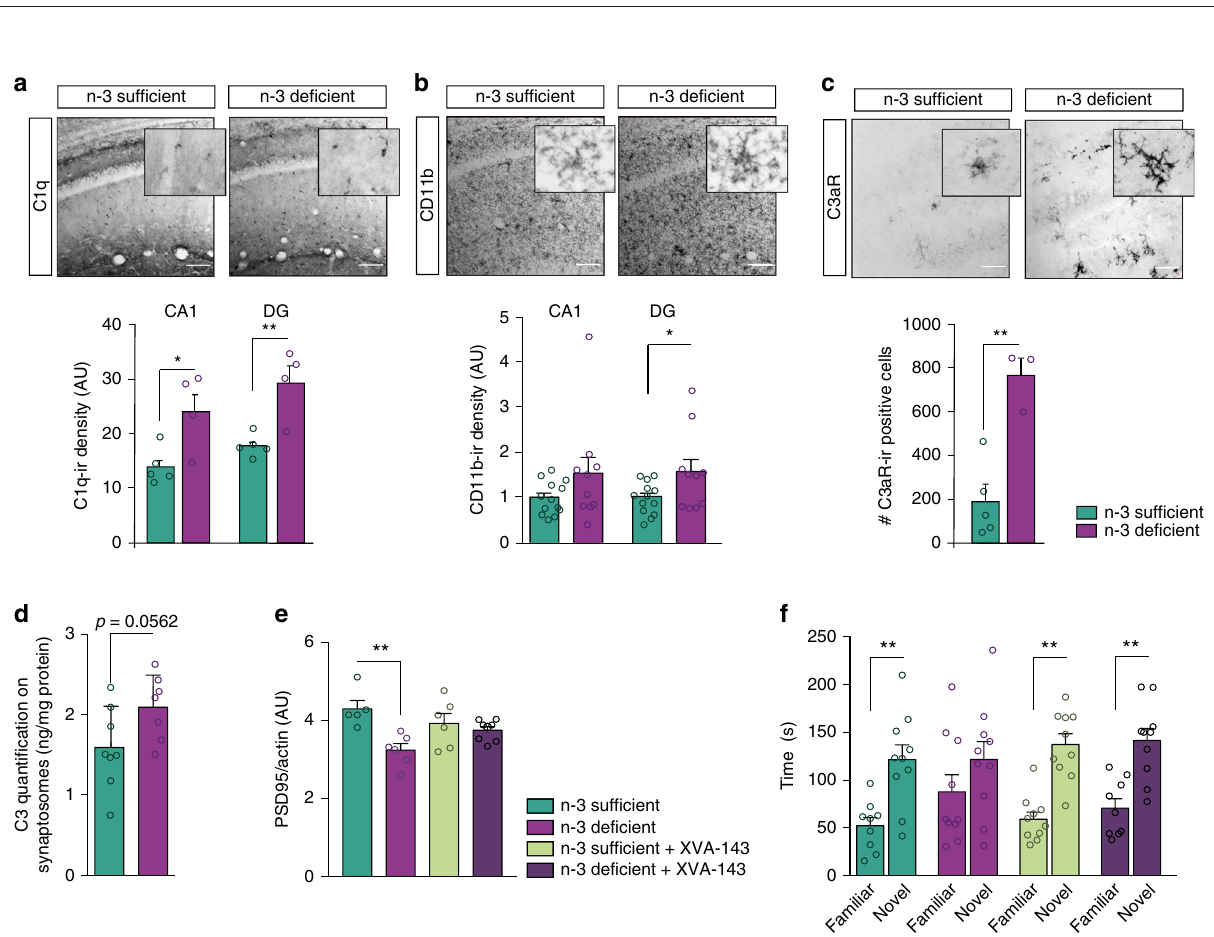
Fig. 3 Maternal dietary n-3 PUFA de fi ciency exacerbates microglial phagocytosis of synaptic elements by predominantly impacting microglia. a Fatty acid composition of microglial cells sorted from n-3 suf fi cient and n-3 de fi cient mice. Means ± SEM; n = 4 mice per group. Insert: higher magni fi cation of low expressed fatty acids. Two-tailed unpaired Student ’ s t -test; t = 3.37, * p = 0.015, C10:0; t = 4.852, ** p = 0.0028, C12:0; t = 2.473, * p = 0.0482, C14:1 n-7; t = 9.646, *** p < 0.0001, DPA n-6; t = 2.558, * p = 0.043, ALA; t = 2.972, * p = 0.0249, DHA; nd not detected. b Fatty acid composition of synaptosomes sorted from n-3 suf fi cient and n-3 de fi cient mice. Means ± SEM; n = 4 mice per group. Insert: higher magni fi cation of low expressed fatty acids. Two-tailed unpaired Student ’ s t -test; t = 2.82, * p = 0.047, C17:0; t = 3.05, * p = 0.038, C18:0; t = 5.05, ** p = 0.0072 C18:1 n-9; t = 2.99, * p = 0.04, C18:2 n-6; t = 26, *** p < 0.0001, C20:2 n-6; t = 3.57, * p = 0.023, C22:4 n-6; t = 12.68, *** p = 0.0002, DPA n-6; t = 4.49, * p = 0.011, C20:5 n-3; t = 7.12, ** p = 0.0021, DHA; nd not detected. c FACS analysis of phagocytic uptake of pHrodo-labeled synaptosomes (sorted from n-3 suf fi cient or n-3 de fi cient mice) by CD11b + microglial cells (sorted from n-3 suf fi cient or n-3 de fi cient mice). Analyses were performed 2 h post-synaptosomes application. On FACS plots: x -axis = (pHrodo intensity (PE intensity), y -axis = SSC. Means± SEM; n = 8 per condition. Two-way ANOVA: microglial fatty acid status effect, F (1,28) = 19.77, *** p = 0.0001; synaptosomes fatty acid status effect, F (1,28) = 1.63, p = 0.2123; interaction, F (1,28) = 0.2826, p = 0.599. Source data are provided as a Source data fi le.